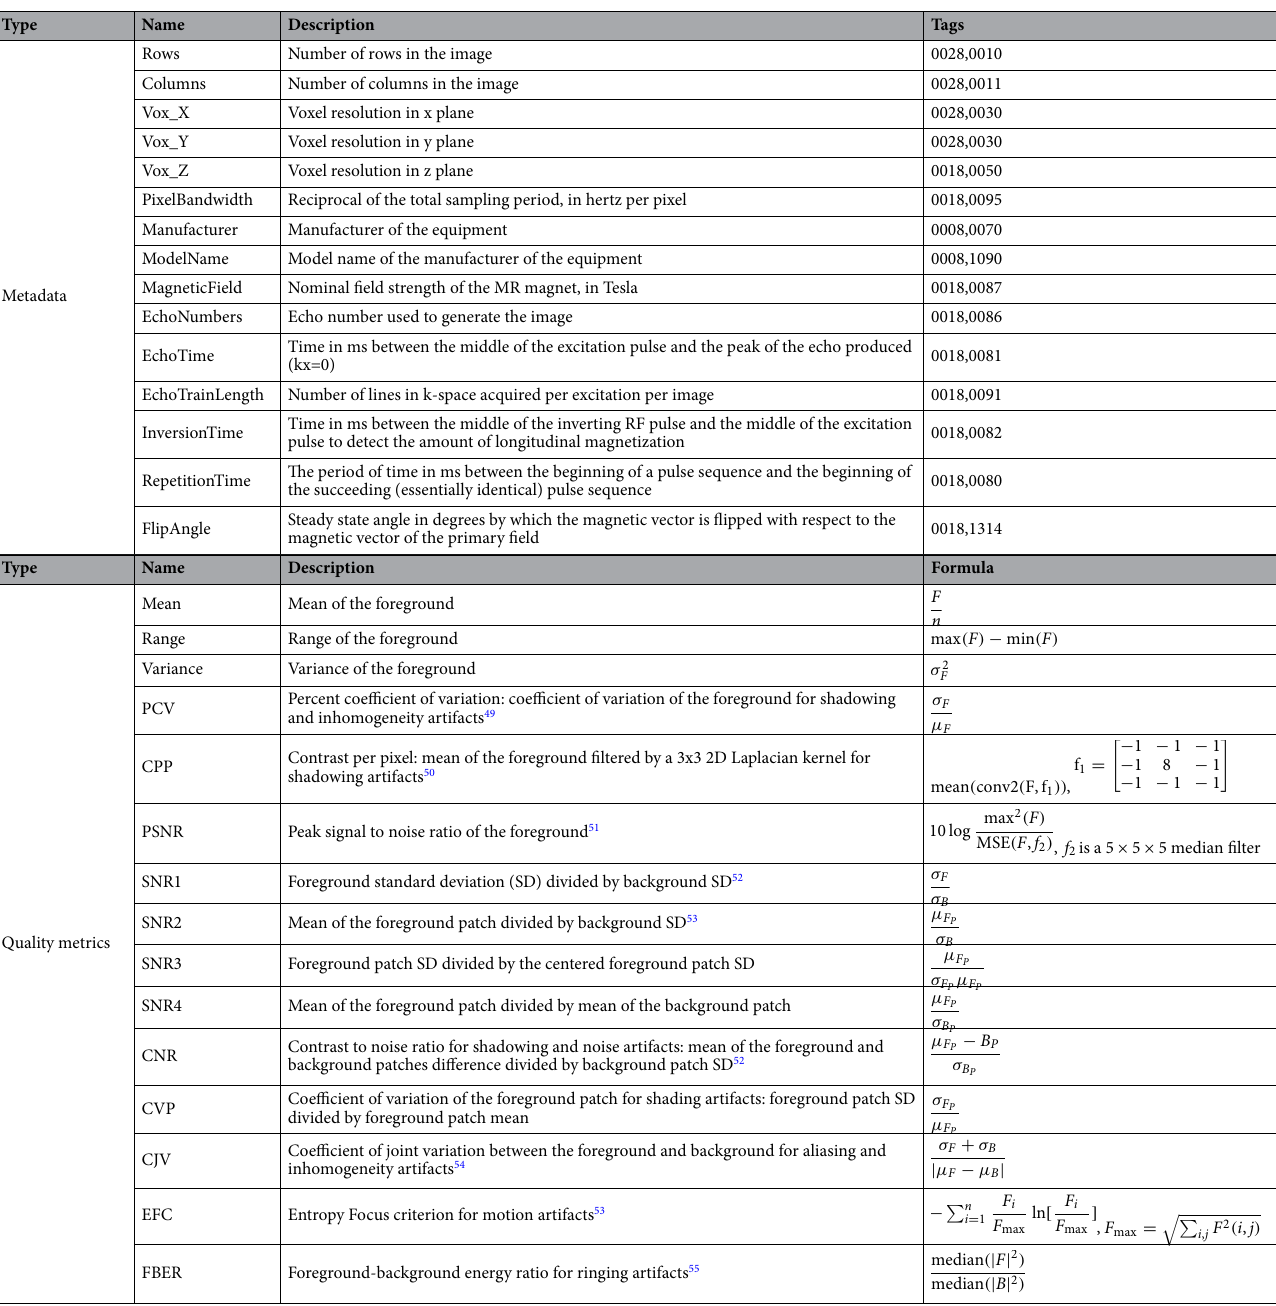
Table 2. Summary table of metadata and quality metrics extracted from the raw DICOM files. F is